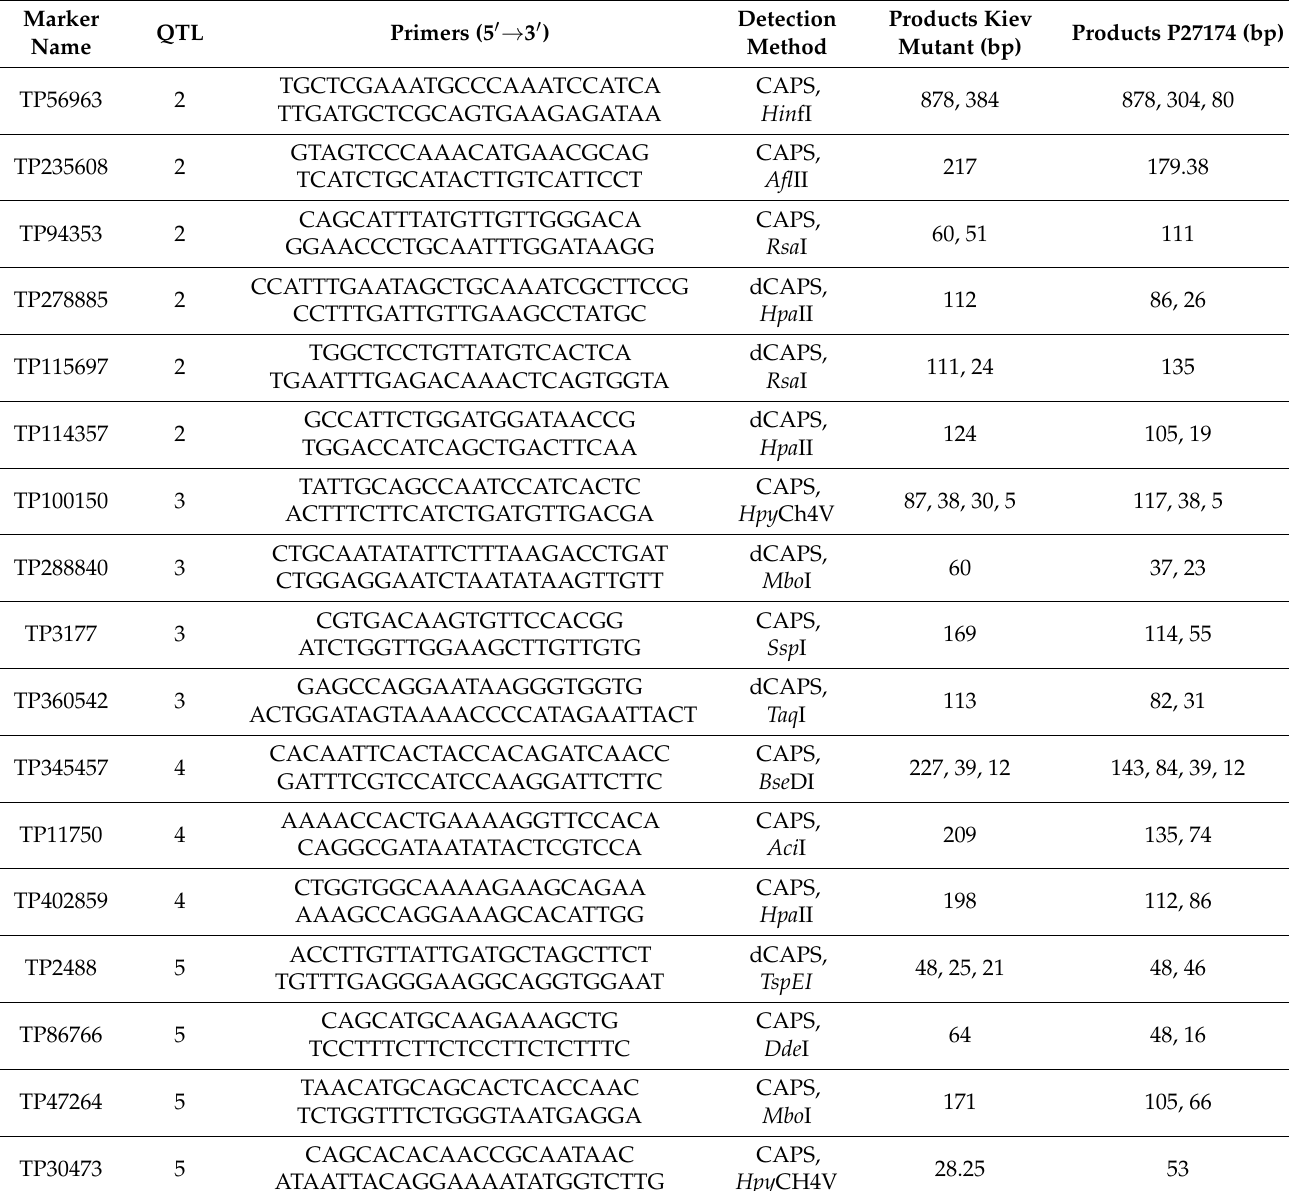
Table 2. New molecular markers developed in this study to supplement marker-assisted tracking of flowering time QTLs in white lupin germplasm